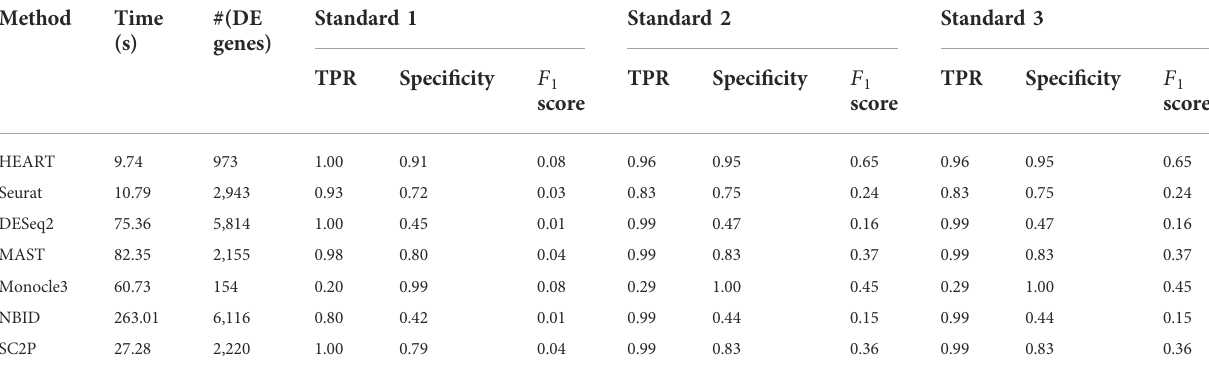
TABLE 1 The time consumption, number of DE genes, TPR, speci fi city, and F 1 score of each method under three different standards (Human brain data).